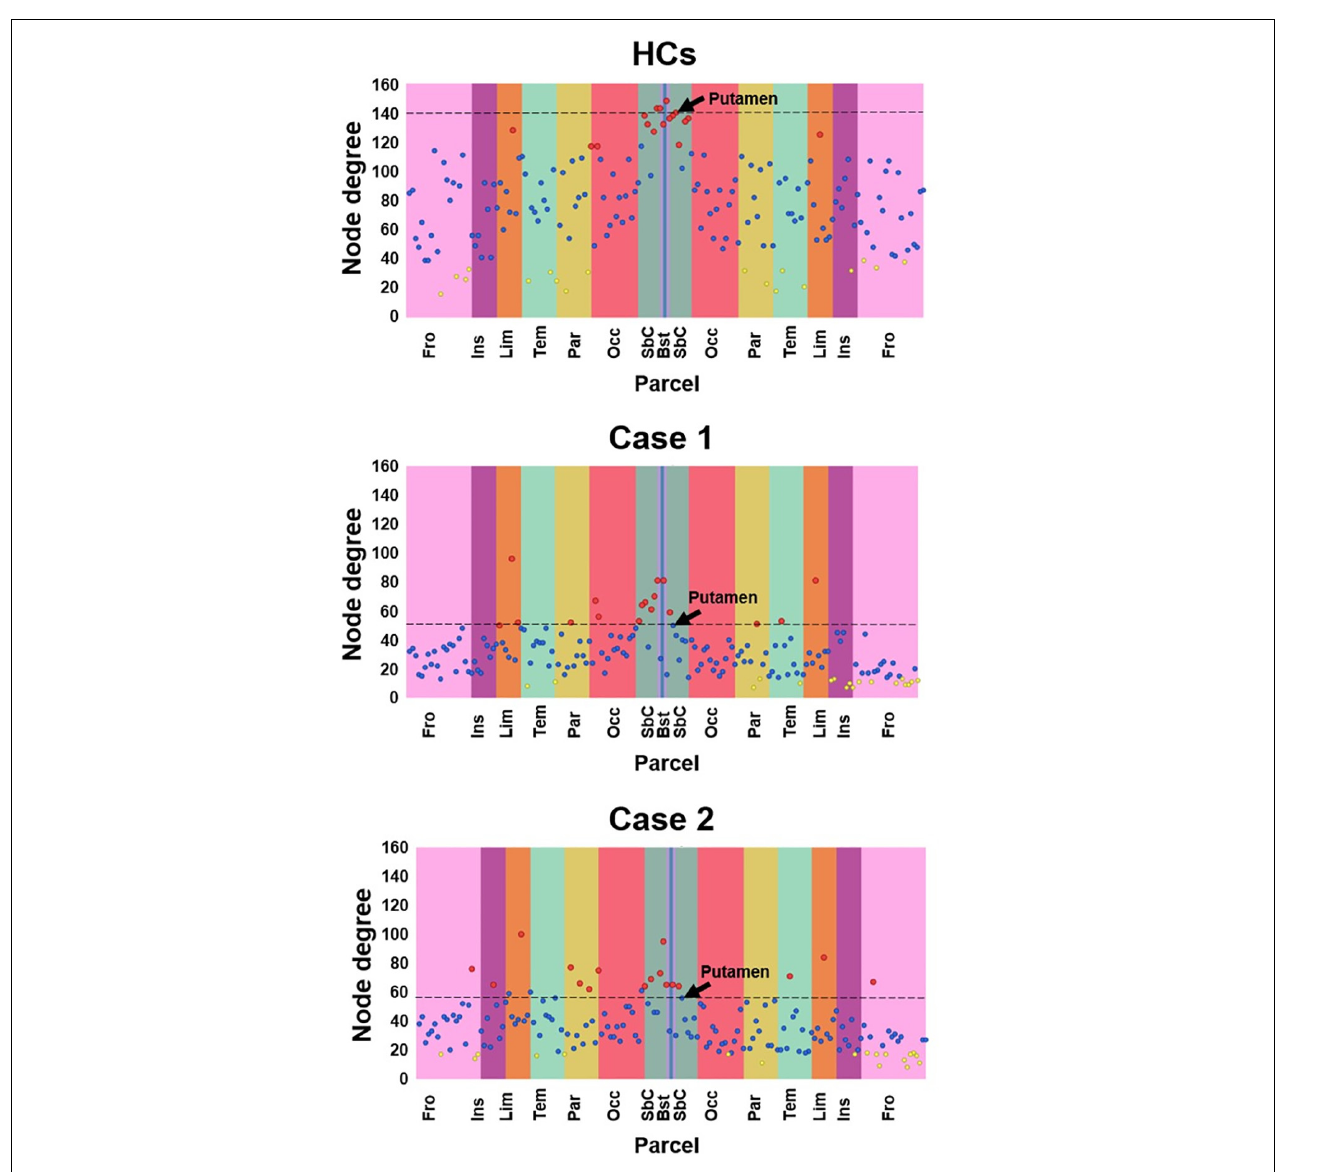
FIGURE 4 | Local node degree computed for HCs, Case 1 and Case 2. The X-axis represent the 165 brain parcels, even if only lobe labels are reported (e.g., Fro). The left hemisphere is represented in the left half of the graph, while the right hemisphere is represented in the right half. Vertical colored stripes represent different lobes (e.g., the frontal lobe is represented in pink). The same lobe in left and right hemispheres is shown with the same color. Each dot in the graph represents the local node degree of a brain parcel. The 17 parcels (10% of 165) exhibiting the highest local node degree are represented as red dots. The 17 parcels (10% of 165) with the lowest local node degree are represented as yellow dots. All the other parcels are represented as blue dots. The SPIDER-NET interactive interface allows to visualize information about each dot, navigating on them. The right Putamen is highlighted by an